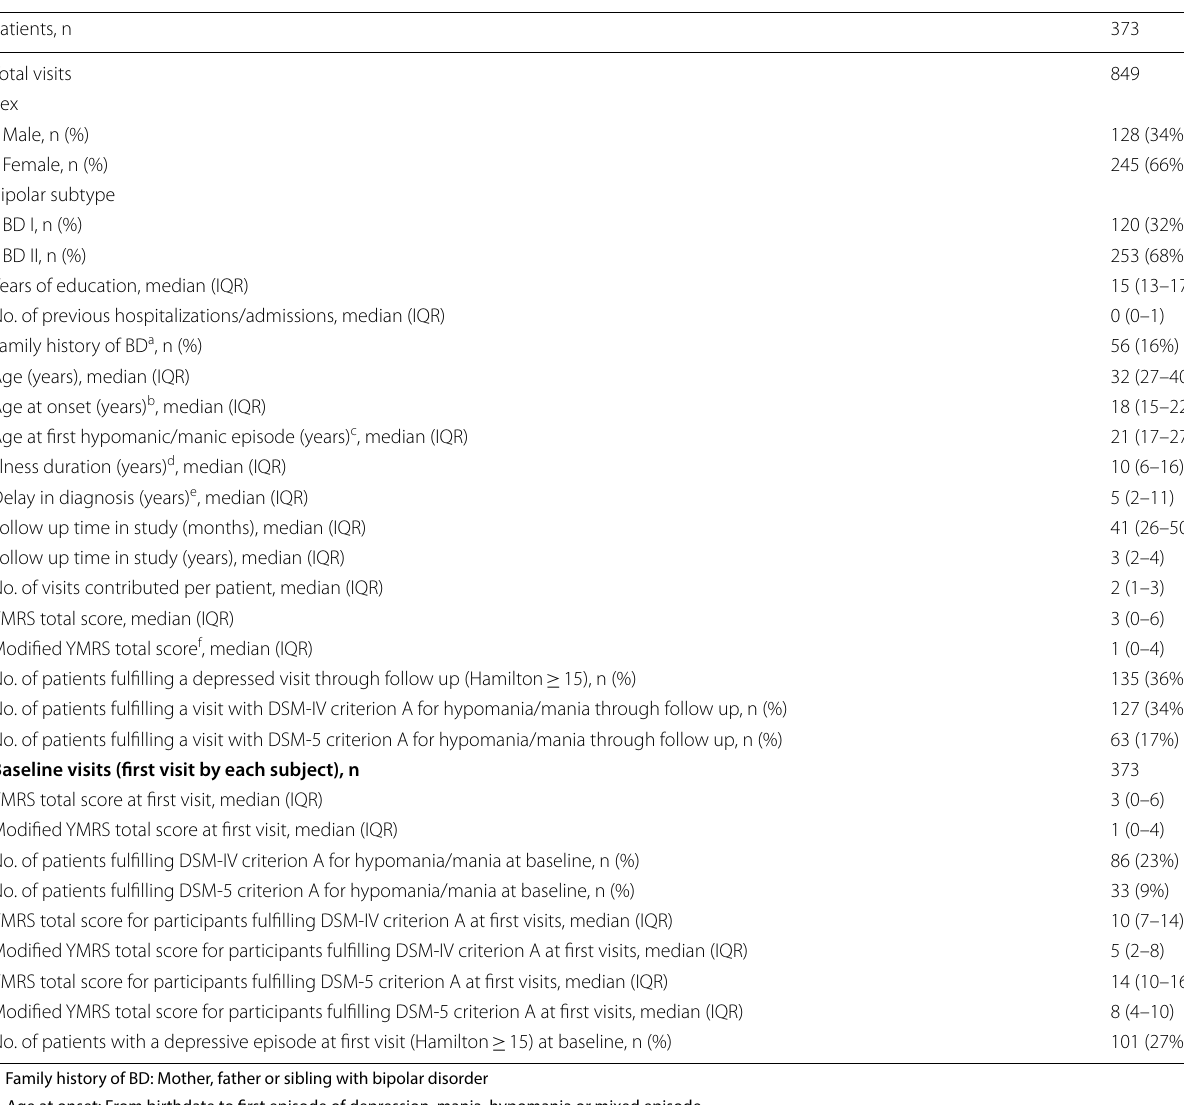
Table 2 Sociodemographic and clinical